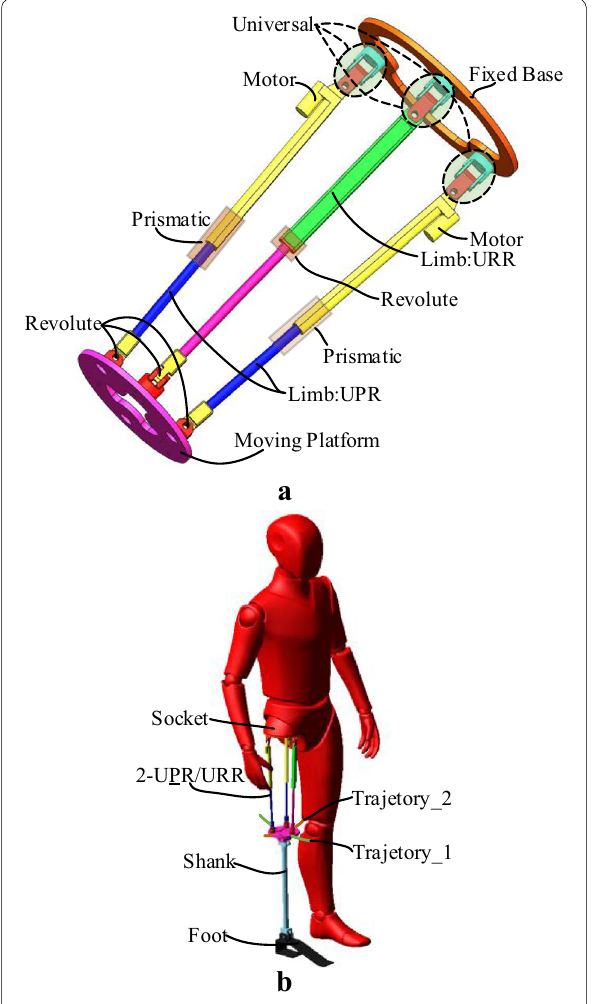
Figure 4 Hip prosthetic parallel mechanism: a 2-UPR/URR parallel mechanism; b amputee with hip prosthetic mechanism